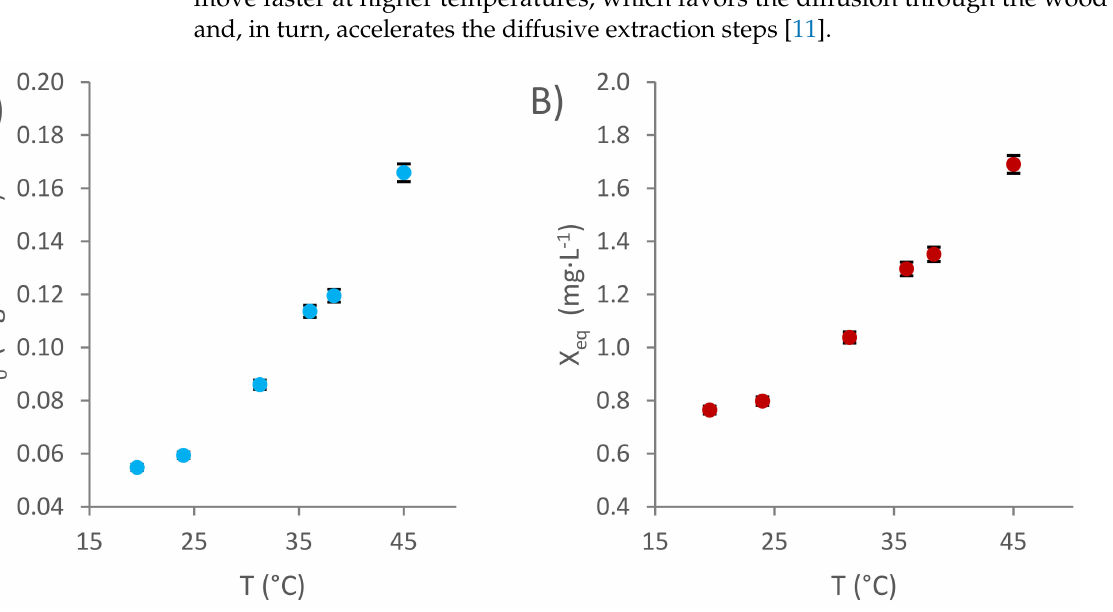
Figure 3. Kinetic parameters at six different temperature levels: ( A ) initial extraction rate and ( B ) theoretical TPI at